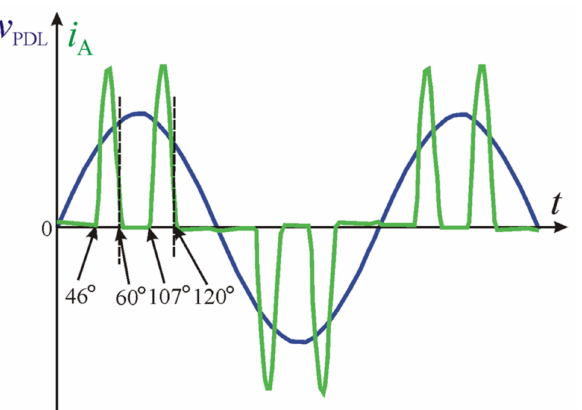
Figure 6. Current and voltage time diagrams at the point of connection of Rockwell Automation PowerFlex 70 three-phase diode rectifier supply-side VFD to the PDL, with a motor supply voltage frequency of 50